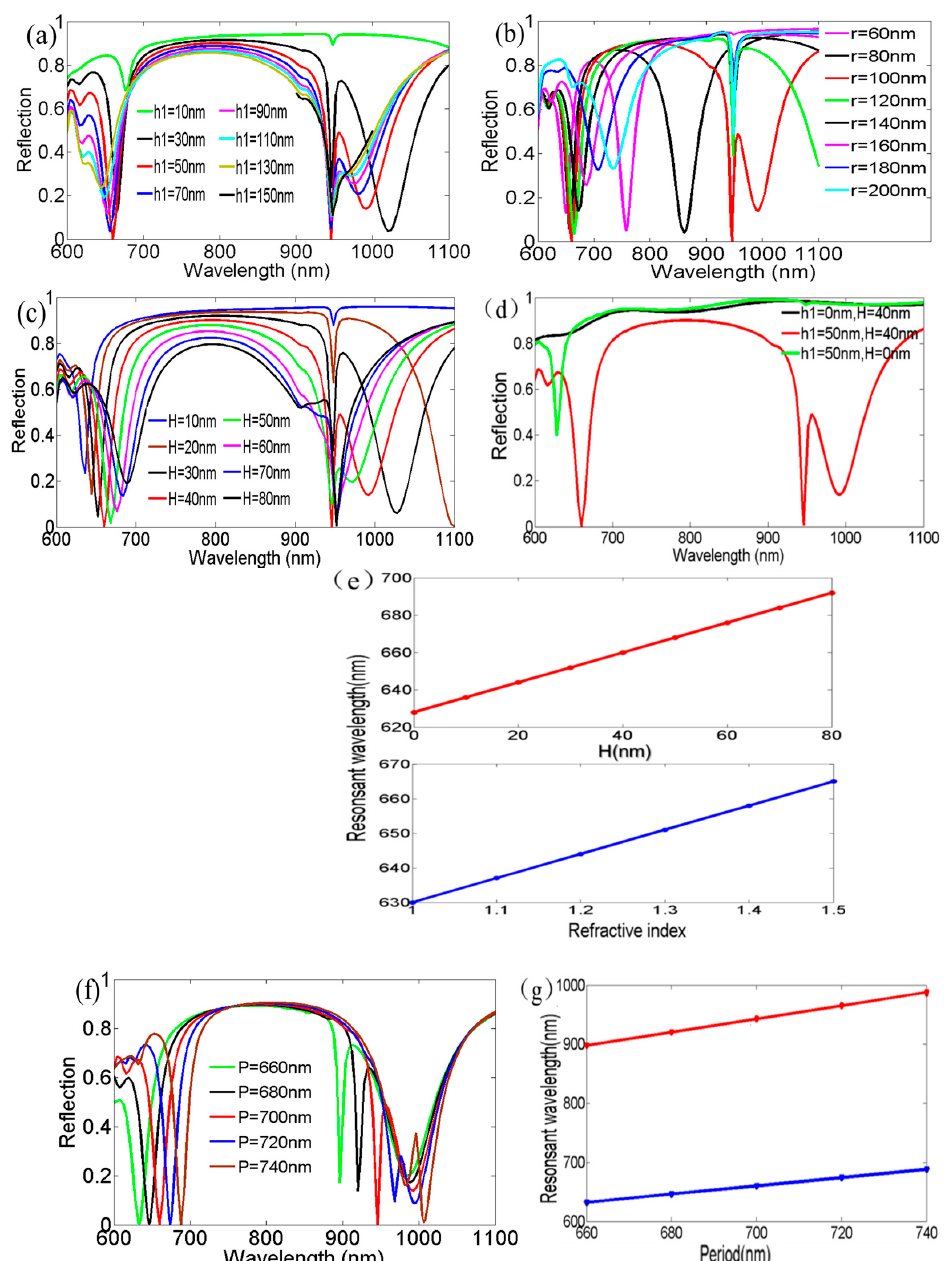
Figure 4. Tuning effects of different parameters on the reflection spectra for the hexagonal nanodisk array at normal incidence. The influence of ( a ) Au disk thickness ( h 1 ); ( b ) Au disk radius r ; ( c ) SiO 2 interlayer thickness ( H ) and ( f ) period ( P ) at both plasmon resonances for the calculated reflection spectra; ( d ) comparison of the reflection spectra for different parameters ( h 1 ) and ( H). The responses of the resonant wavelength at the first plasmon resonance for ( e ) different SiO 2 interlayer thickness ( H ) and SiO 2 interlayer RI and ( g ) period (P).